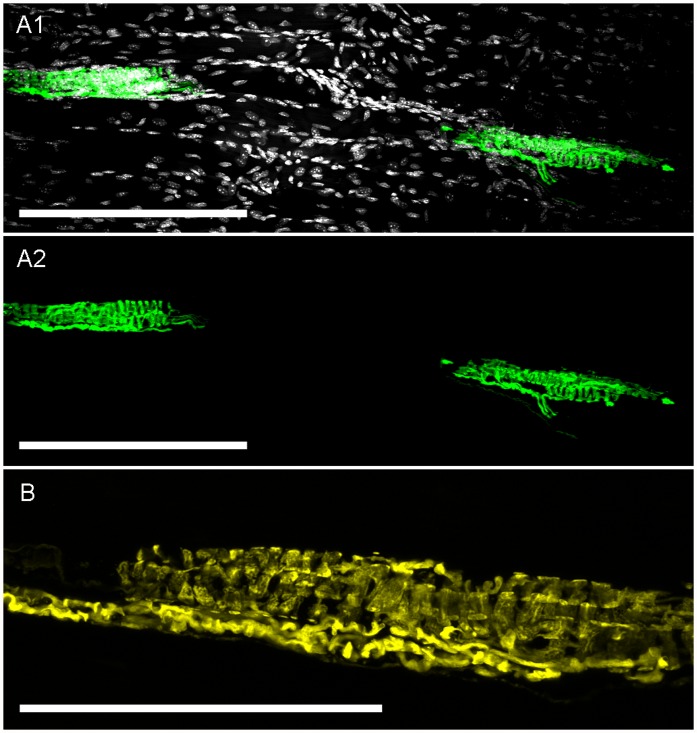
Confocal imaging of YFP expression in skeletal muscle spindles.
A1, YFP-expressing muscle spindles in deep tissue of tibialis anterior skeletal muscle. YFP is shown in green and DAPI is shown in greyscale, scale bar represents 200 μm. A2, as A1 but without DAPI staining for clarity. B, fine structure of another YFP-expressing muscle spindle. YFP is shown in yellow, scale bar represents 100 μm.